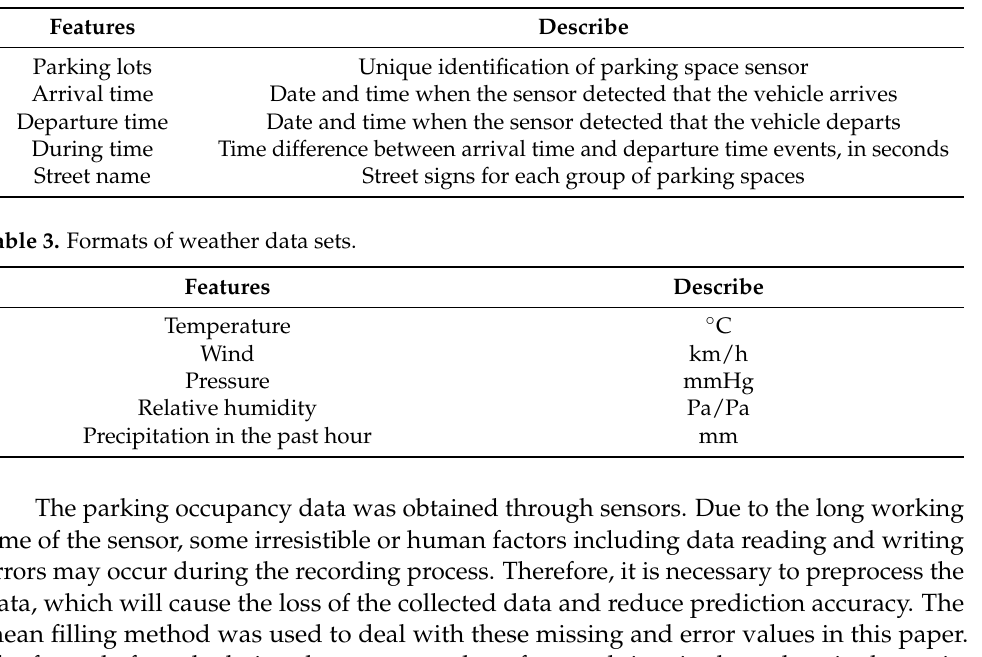
Table 2. Formats of parking data sets.